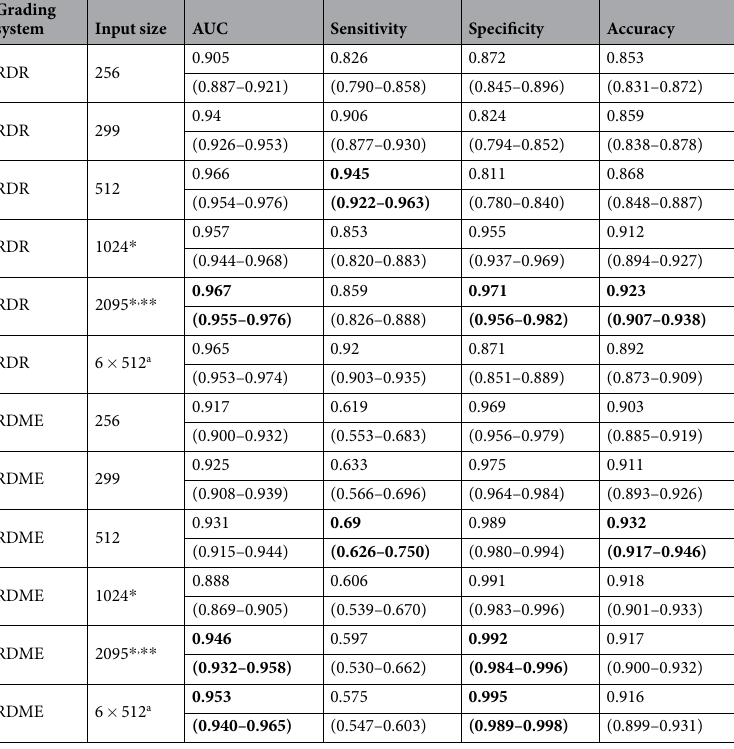
Table 5. Classification results for predicted of RDR and RDME with varying input image sizes on the Messidor dataset. Classification on the Messidor set 15 . Sensitivity, specificity and accuracy measured at 0.900